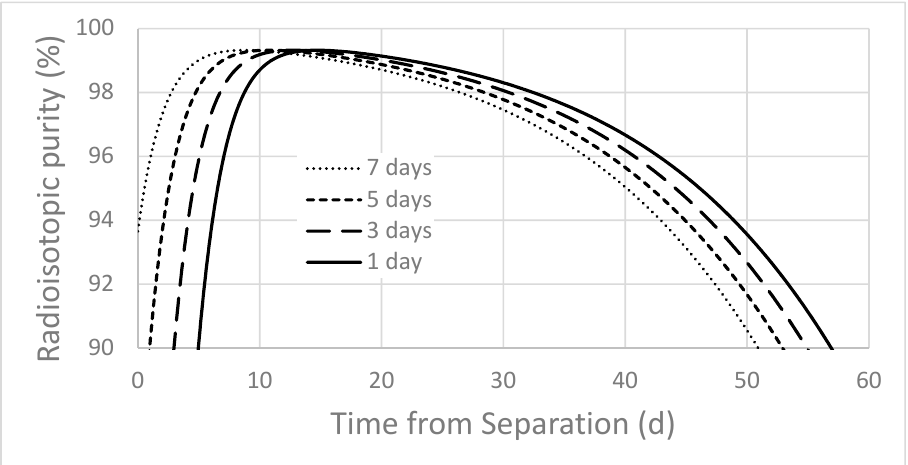
Figure 2. Radioisotopic purity of Ac-225 as a function of time from final chemical purification. The four curves depict the various durations between the EOB and the final purification. These values represent the radioisotopic purity of Ac-225, only considering all actinium isotopes (radioisotopic purity from Figure